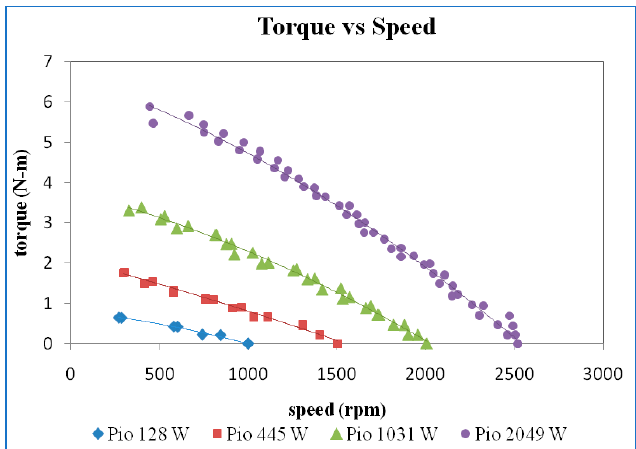
Figure 9. Torque vs. speed at a guide vane opening of 10 mm.